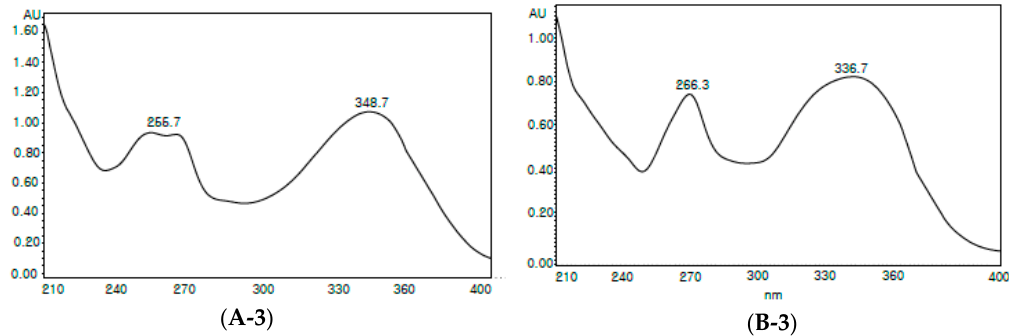
Figure 1. The structure and purity of luteolin-7- O -diglucuronide and apigenin-7- O -diglucuronide f rom Perilla frutescens var. acuta (PFA). ( A-1 ) The structure of luteolin-7- O -diglucuronide. ( A-2 ) HPLC profile of luteolin-7- O -diglucuronide. ( A-3 ) The UV spectrum of luteolin-7- O -diglucuronide. ( B-1 ) The structure of apigenin-7- O -diglucuronide. ( B-2 ) HPLC profile of apigenin-7- O -diglucuronide. ( B-3 ) The UV spectrum of apigenin-7- O -diglucuronide.